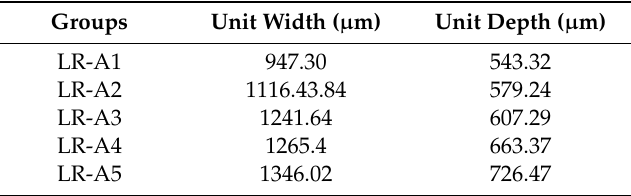
Figure 5. The cross-section of the biomimetic units: ( a ) LR-A1, ( b ) LR-A2, ( c ) LR-A3, ( d ) LR-A4, and ( e ) LR-A5. Table 3. Unit characteristics of di ff erent